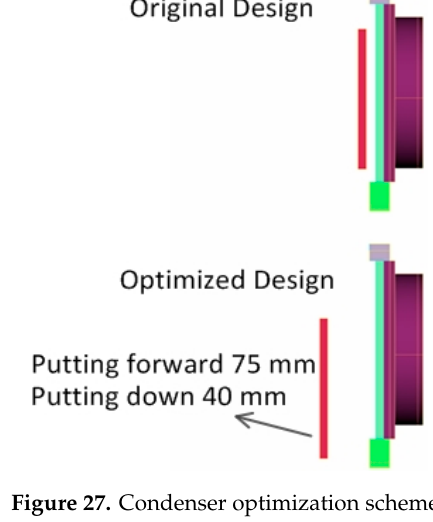
Figure 26. Radiator optimization scheme.